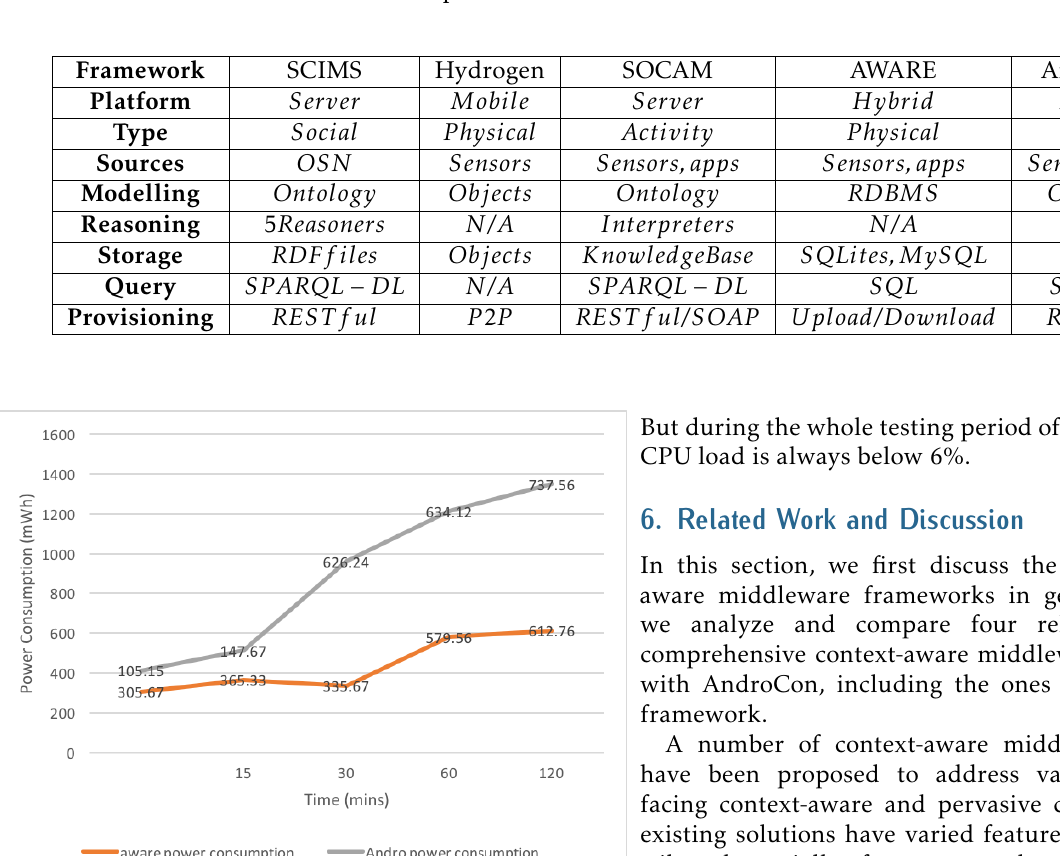
Table 4. : Comparisonof Five Context-AwareMiddlewareFramework